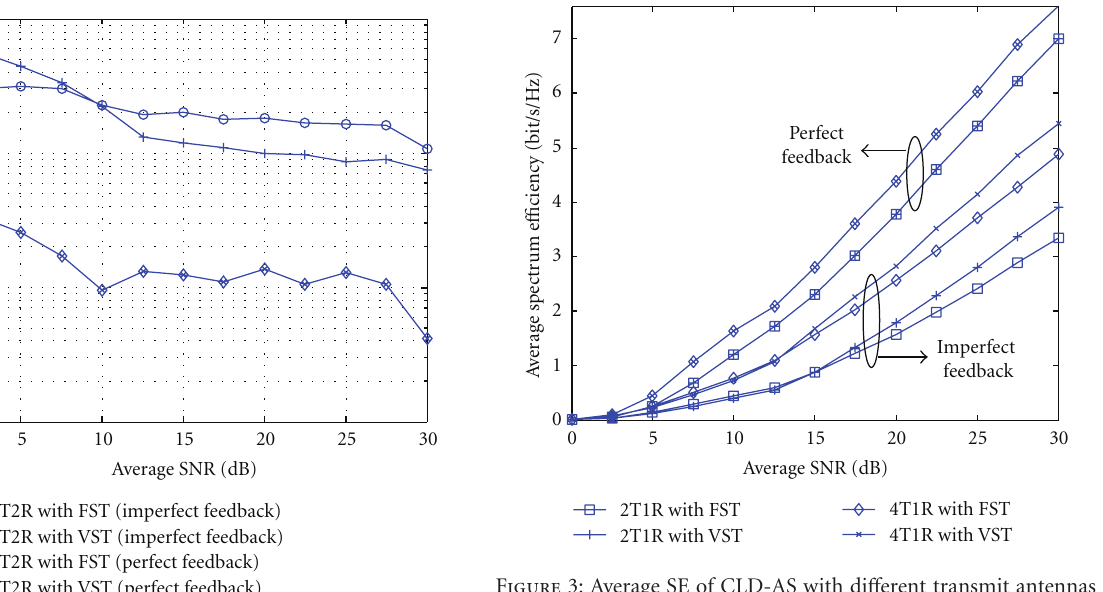
Figure 2: Average PER of CLD-AS with two transmit antennas and two receive antennas.